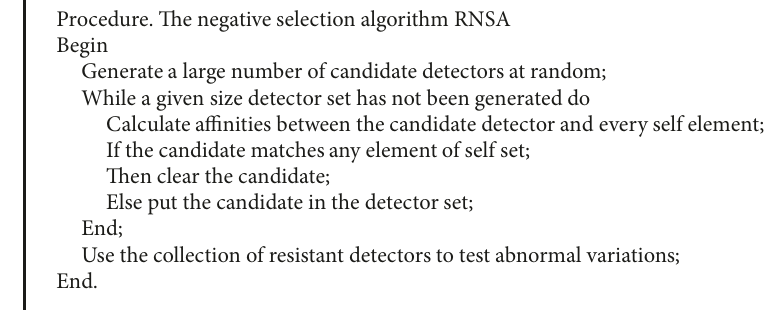
Algorithm 1: The process of RNSA.